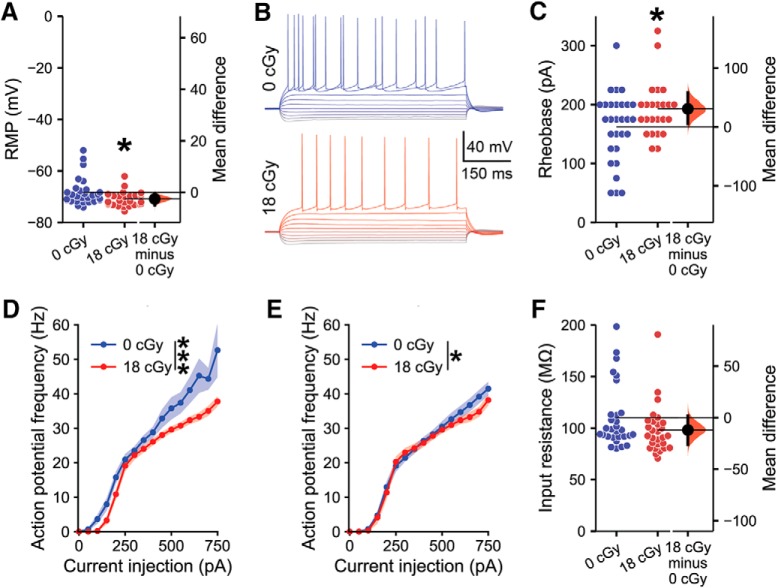
Neutron irradiation alters the electrophysiological properties of CA1 pyramidal neurons. All data are from whole-cell current-clamp recordings of CA1 pyramidal neurons from the superficial layer of the dorsal hippocampus, 6 months following the completion of 18 cGy neutron irradiation. A, RMP was decreased following neutron irradiation. B, Representative examples of responses to a range of brief current injections in neurons from 0 cGy control and 18 cGy mice. C, The rheobase current required to evoke an action potential was greater in neutron-irradiated animals compared with concurrent controls. D, Action potential frequency was attenuated across a range of current injections in 18 cGy neurons, (E) including in a subset of neurons with an RMP within −69.6 ± 3 mV. F, There was no significant alteration in input resistance. N = 8/7 animals, 29/28 cells (0 cGy and 18 cGy, respectively), except for E, where N = 23/16 cells. Gardner–Altman estimation plots show raw data on the left axis and a bootstrapped sampling distribution on the right axis. A black dot depicts the mean difference between groups and the 95% CI is indicated by the ends of the vertical black bars. Data are presented as mean ± SEM for D and E. *p < 0.05, ***p < 0.001 (MLM regression or two-way ANOVA).